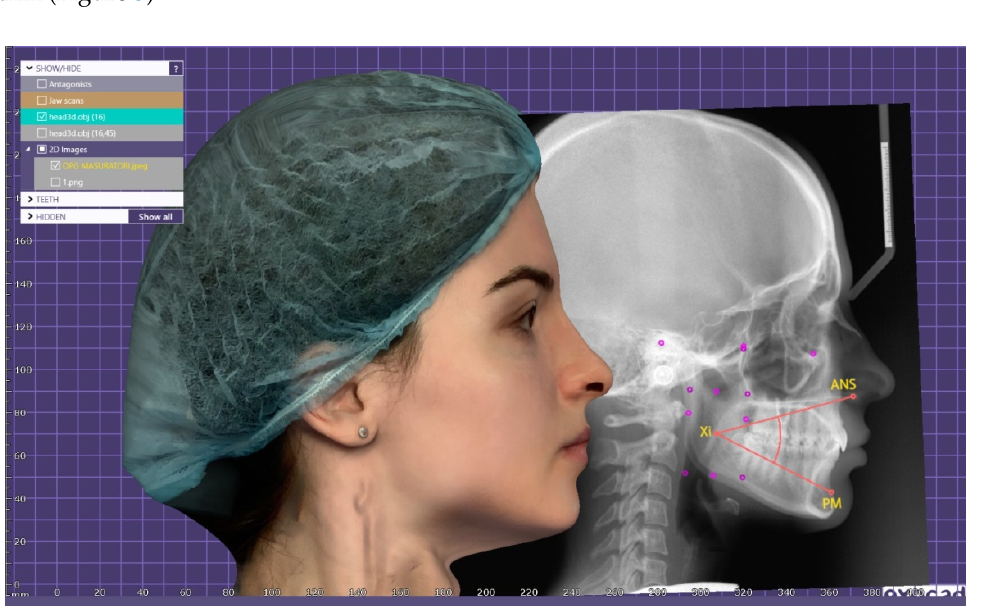
Figure 3. Superimposition, based on the best-fit algorithm, of .obj file (facial scan) with a dicom image of the lateral cephalogram performed in Exocad software.